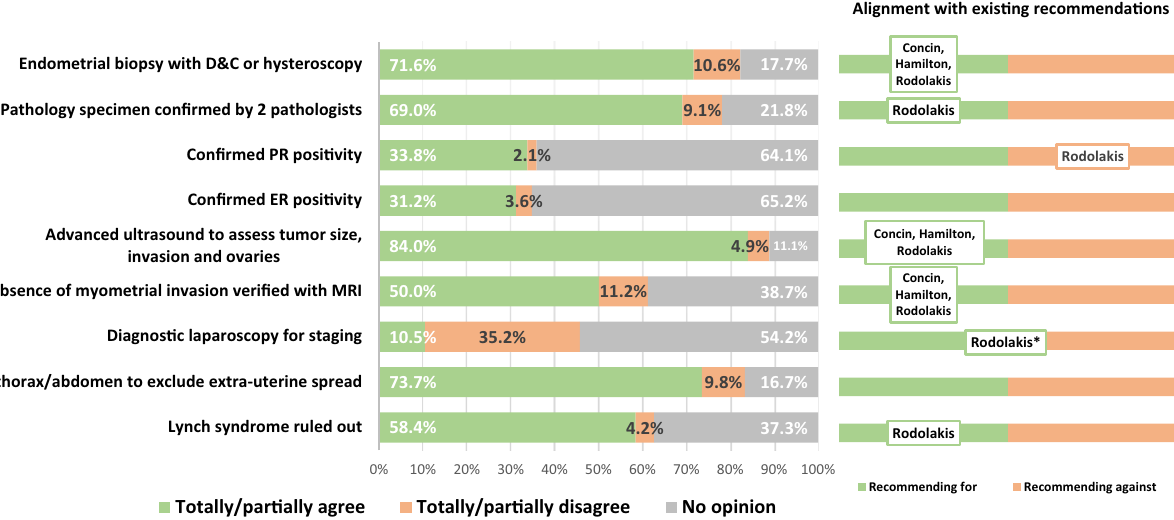
Figure 4. Oncology-specific diagnostic criteria for conservative management of endometrial cancer in the study population as well as in relation to international recommendations and guidelines. D & C Dilatation and curettage, PR progesterone-receptor, ER estrogen-receptor, MRI magnetic resonance imaging, CT computerized tomography. Question subset B was delivered to clinicians active in endometrial cancer care (N = 156). Response rate > 88% for all items. Citations with author names presented within the chart bars to the right refer to published guidelines recommending for/against individual diagnostic criteria. *Recommendation to discuss laparoscopy with the patient 6–8